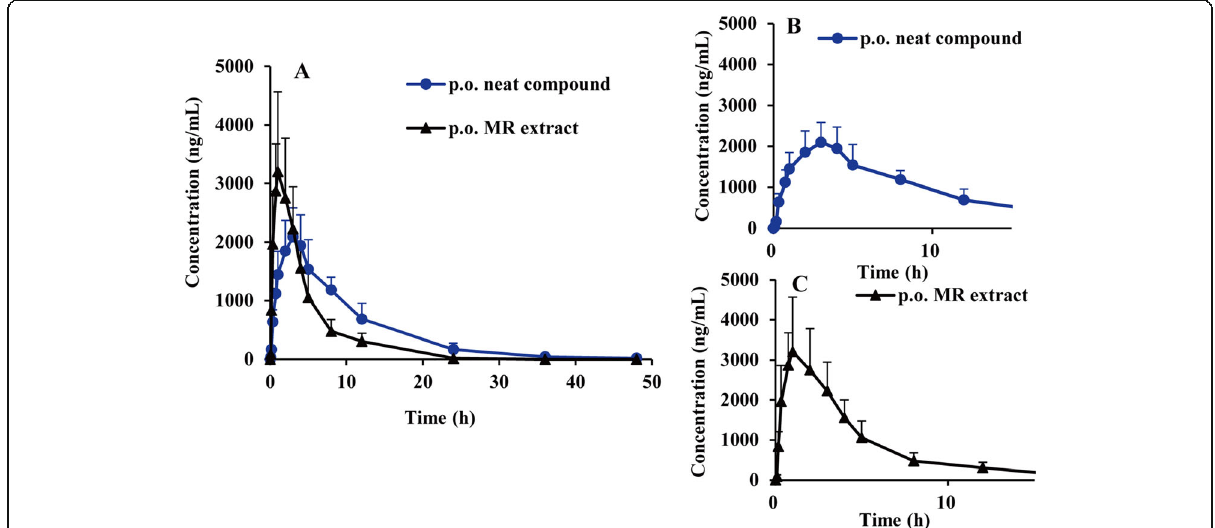
Fig. 3 Plasma concentration-time curves of DMP in rats following oral (p.o.) administration of pure DMP (1 mg/kg) and Menispermi Rhizoma extract (1.605 g/kg, dose equivalent to 1 mg/kg DMP): a comparison of two concentration-time curves, b pure DMP, and c Menispermi Rhizoma extract. Each value displays mean ± SD, n =